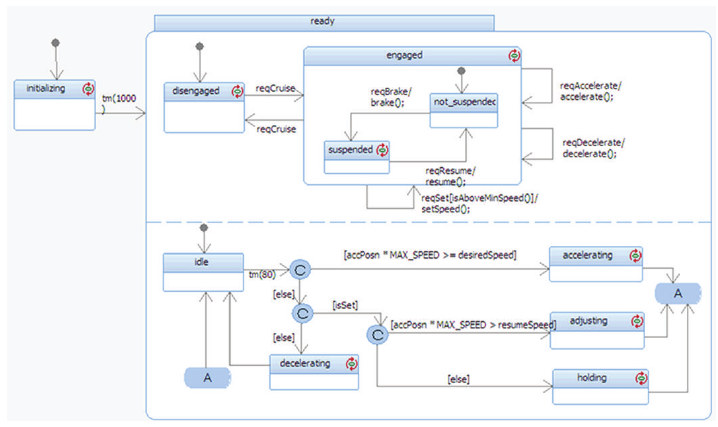
Figure 25: A state machine diagram of Controller block.